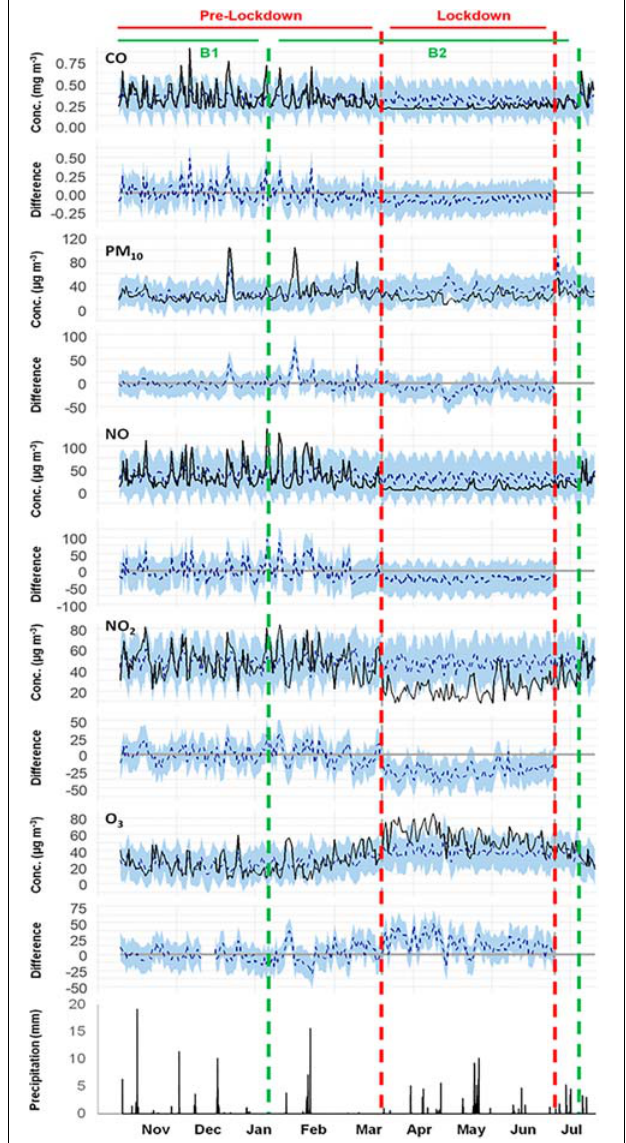
FIGURE 1 | Representation of the concentrations of atmospheric pollutants in Barcelona during the lockdown of 2020 and the corresponding Bayesian model predictions. The pre-lockdown/lockdown and the PAS-sampled B1/B2 periods are delimited by dashed, vertical, red and green lines, respectively. For each compound, the top graphs show daily average concentrations recorded in 2020 (black continuous line) against a counterfactual prediction based on 2018–2019 average values (blue dashed line). The bottom graphs show the difference between the observed data and the counterfactual predictions if lockdown had not occurred. From data of the air monitoring stations of the Catalan